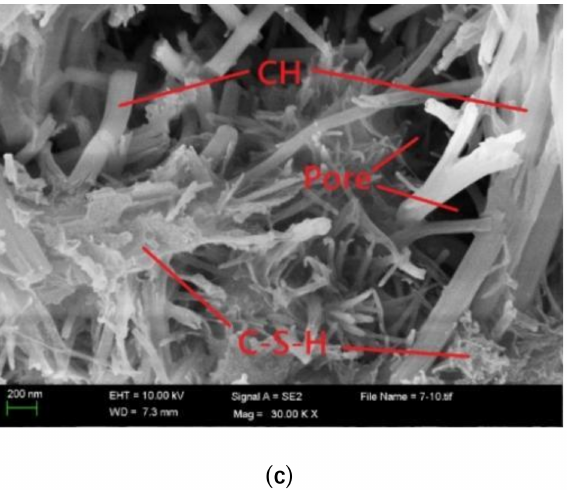
Figure 5. SEM images of hydration products. ( a ) D − 0 group; ( b ) D − 20 group; ( c ) M − 1 group.